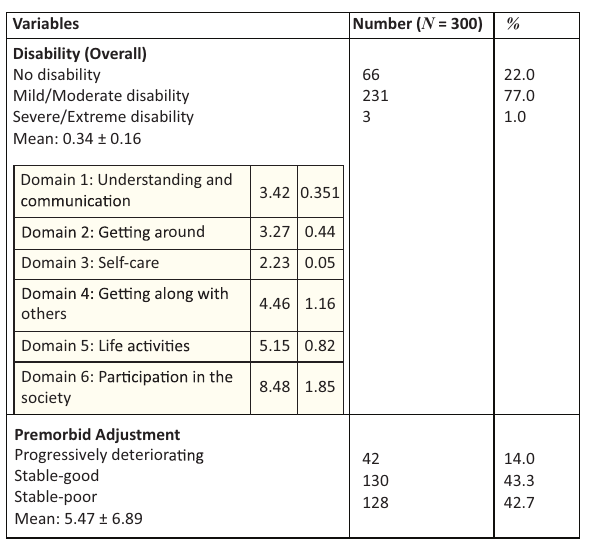
FIGURE 2: Prevalence of disability and premorbid adjustment